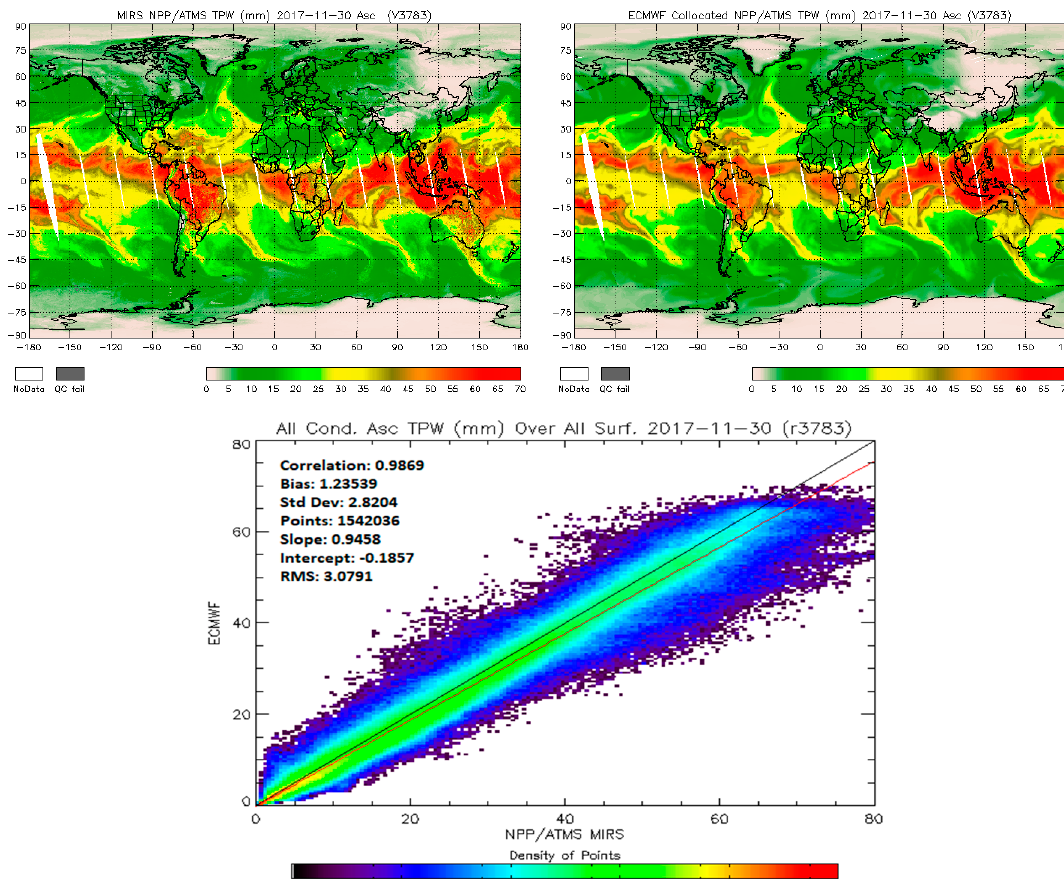
Figure 13. MiRS total precipitable water ( upper left panel ) compared to ECMWF analysis fields ( upper right panel ). The scatter plot ( lower panel ) shows very good agreement with a correlation higher than 0.98 between MiRS retrieved and ECMWF TPW. (Figure courtesy: Quanhua Liu, STAR MiRS team). Table 12. S-NPP MiRS temperature/moisture profile performance*.